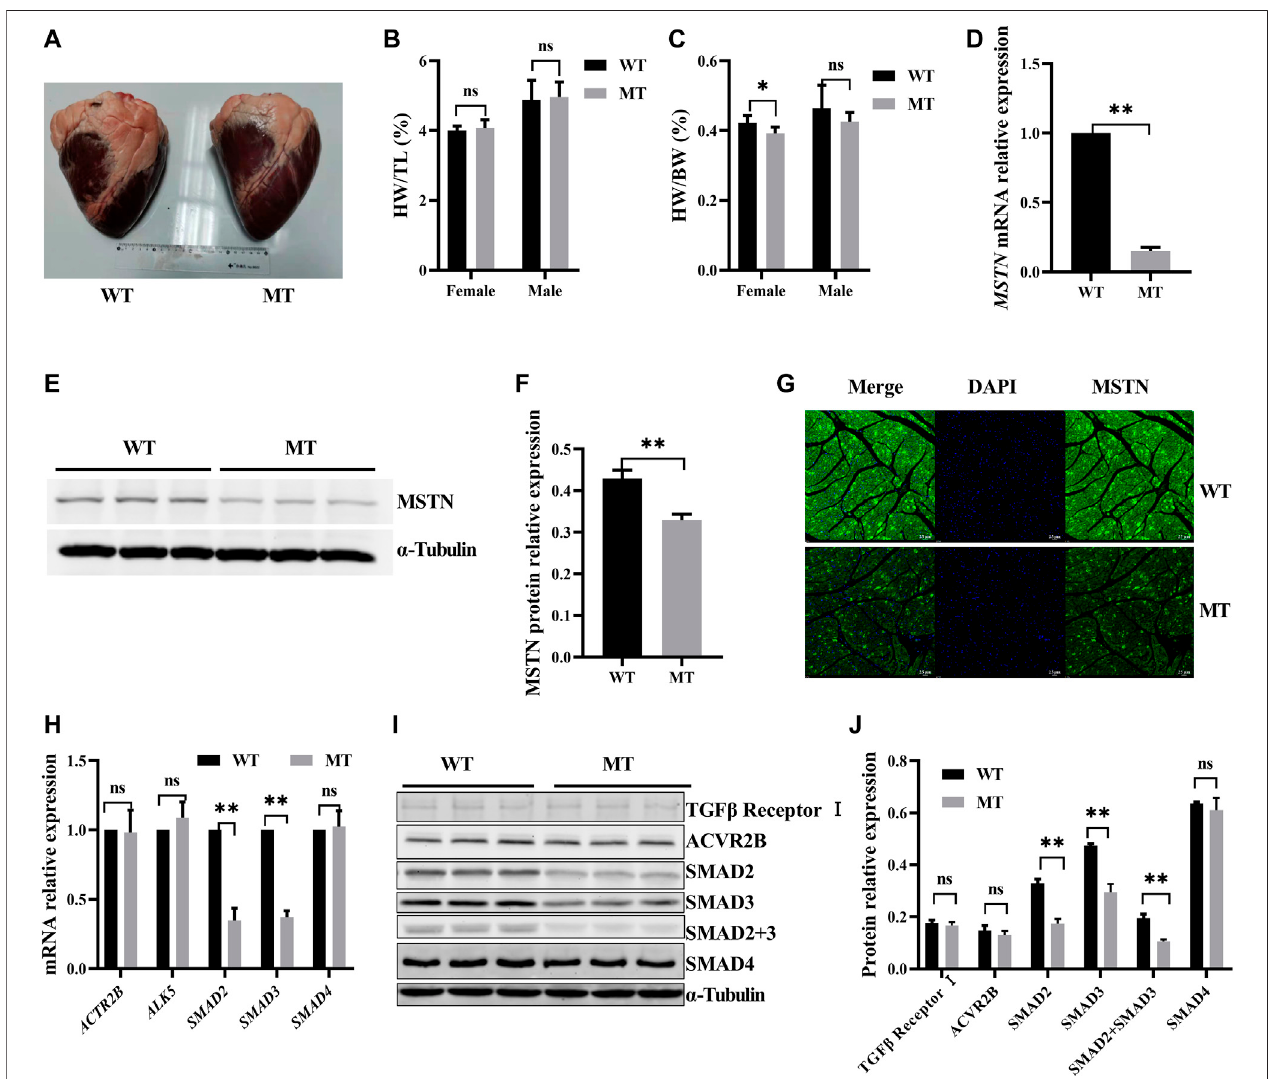
FIGURE1| MyostatinmutationdecreasedSMAD2/3expressionbuthadnoeffectoncardiacanatomyofcattle. (A) WholeheartimagesofMTandWTcattle. (B,C) Statistical results of heart weight (HW)/tibial length (TL) and HW/body weight (BW) in MT and WT cattle. (D) Expression of MSTN mRNA in heart of MT and WT cattle. (E,F) ExpressionofMSTNproteininheartofMTandWTcattle. (G) RepresentativeexpressionofMSTNimmuno fl uorescenceimagesofheart(green,MSTN;blue,nuclei; scalebar,25 μ m). (H) ExpressionofMSTNsignalingpathwayfactormRNAinheartofMTandWTcattle. (I,J) ExpressionofMSTNsignalingpathwayfactorprotein in heart ofMT and WT cattle. All data arepresented asmean ±SD. Compared with theWT group, * p < 0.05, ** p < 0.01, ns: no signi fi cant; t -tests were used to calculate the p -values.